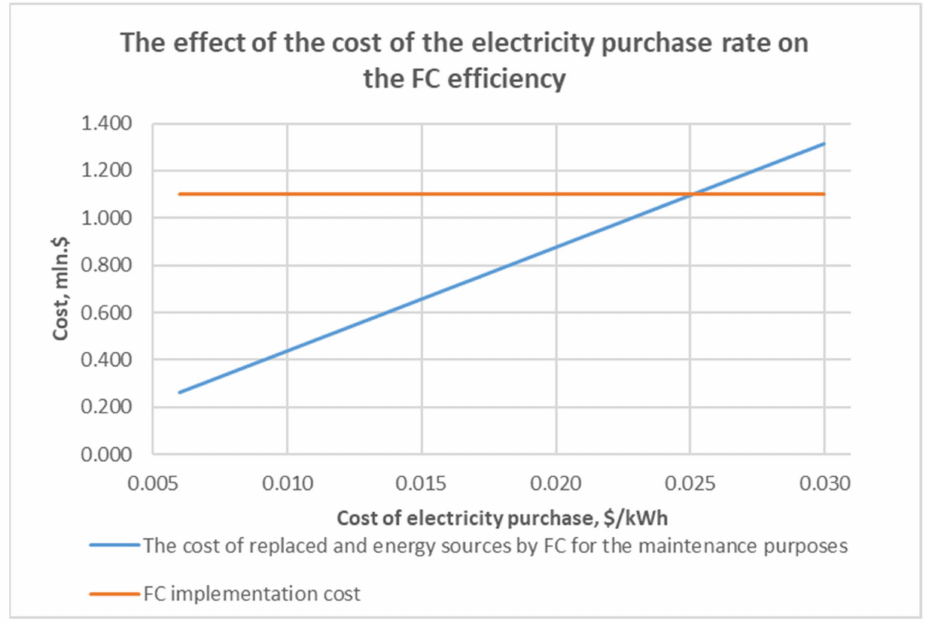
Figure 5. The effect of the cost of the electricity purchase rate on the FC efficiency in the case of covering the economic needs of the station by FC.